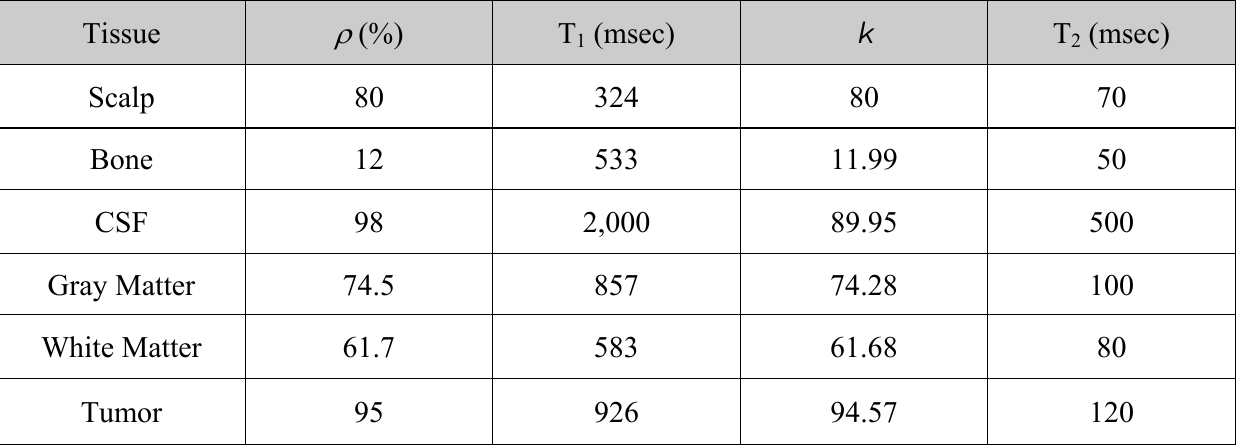
Table 2 . Spin density and relaxation times for the Shepp-Logan phantom. The k values = 5,000 have been obtained using T R